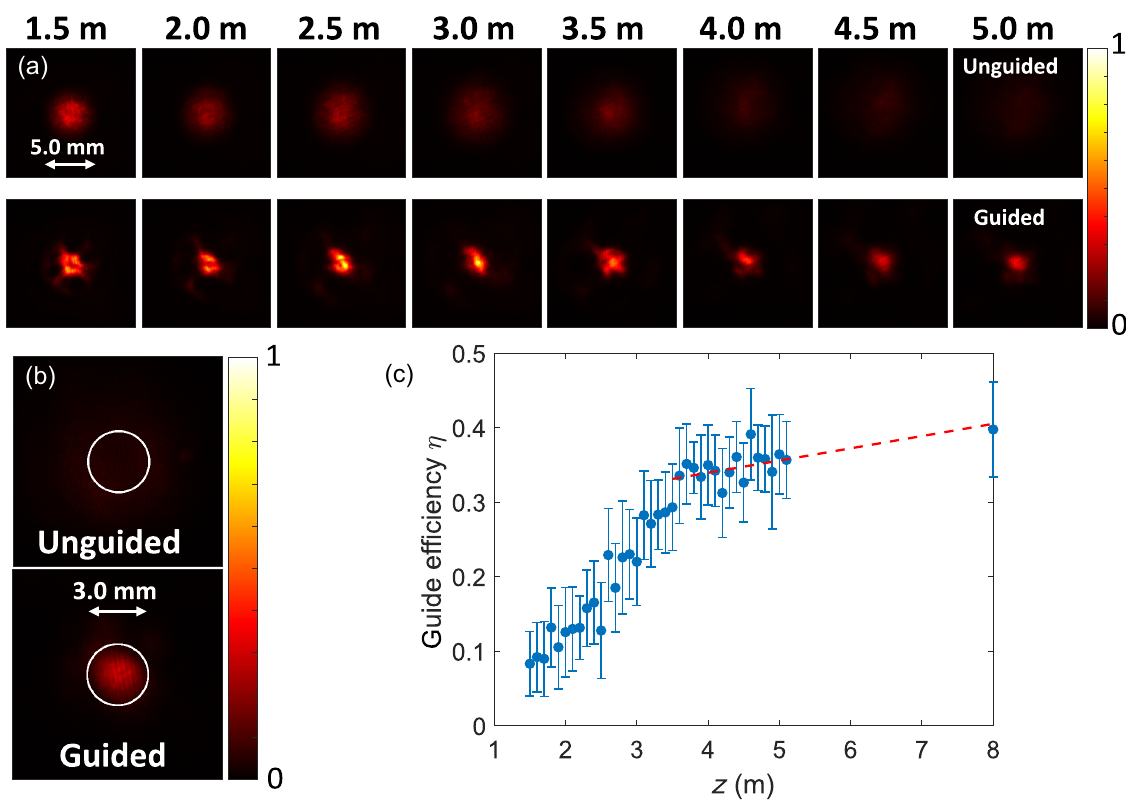
FIG. 6. Optical guiding of a 1-mJ, 7-ns, λ ¼ 532 -nm probe pulse injected at 800 - μ s delay into an air waveguide formed by an 80-mJ, 3 mm. (a) 50-shot-average images of unguided (top row) and guided (bottom row) mode vs propagation 100-fs LG 01 pulse with d ring ¼ distance, with the same scale as Fig. 5(a). The guided-mode diameter is ∼ 2 mm. (b) Images at z ¼ 8 m of the unguided and guided 3 -mm-diameter circles contain the guided and unguided energy used in the definition of guiding efficiency. modes. The d ring ¼ − E − E = ð E (c) Guiding efficiency η ¼ ð E vs propagation distance measured with the helium cell. Each point is a 50-shot g ug Þ tot ug Þ average, with the bars showing the (cid:3) standard deviation. The gap between points at z ¼ 5 . 3 and 8 m is due to helium cell travel constrained by our optical table arrangement. The dashed red line is a linear fit to the points > 3 . 5 m to guide the